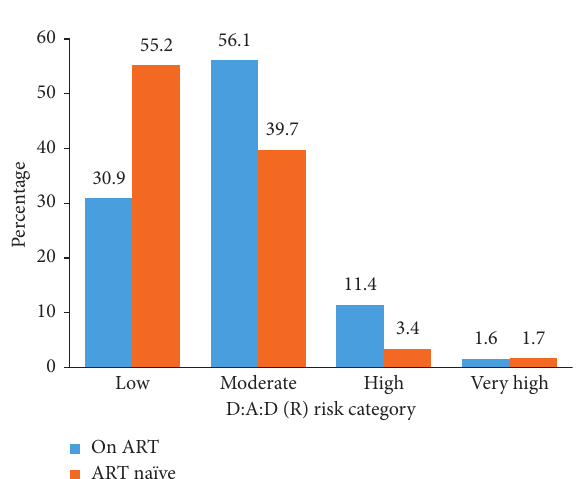
Figure 2: D: A: D(R) 5-year risk of CVD development by ART status ( n � 181 ∗ ). ∗ D :A :D risk score could not be calculated for a participant as the age was above 80 years.